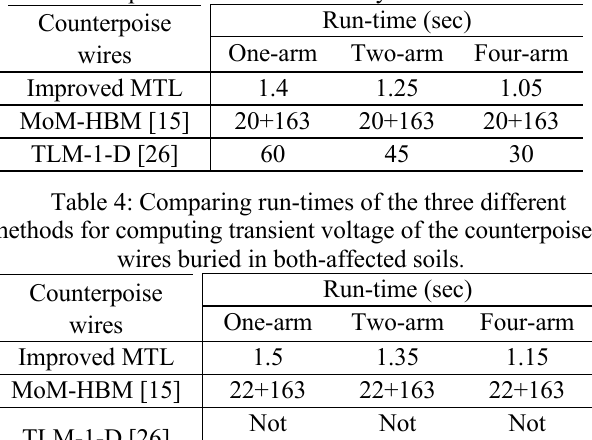
Table 3: Comparing run-times of the different approximate methods for computing transient voltage of the counterpoise wires buried in only-ionized soils .